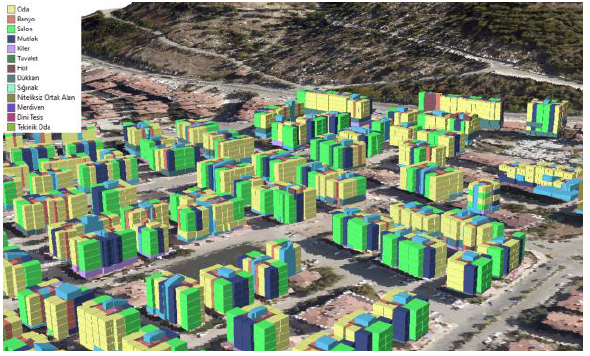
Figure 9. Example of Viewshed-1 (CityGrid)